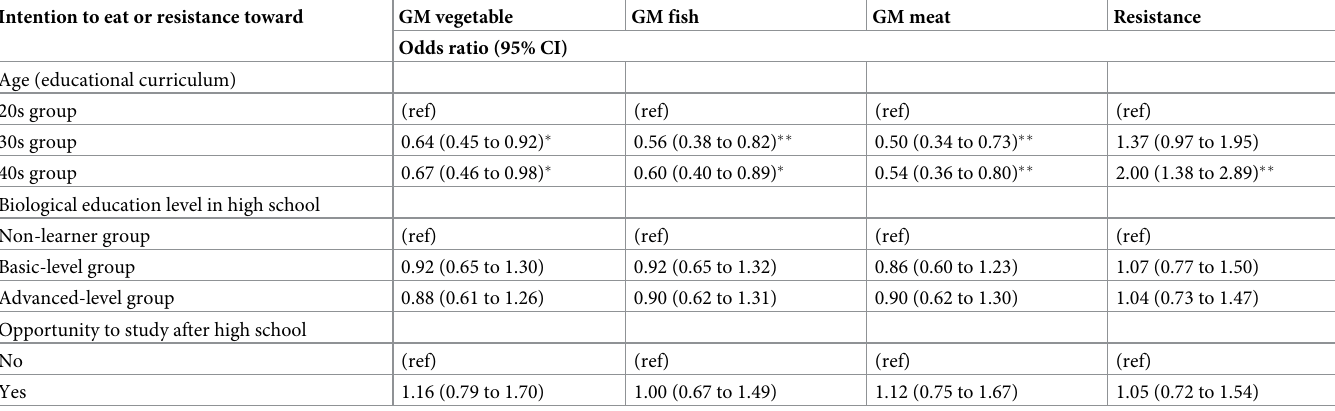
Table 6. Odds ratios of logistic regression analysis explaining acceptance of GM food according to high school biology education. Intention to eat or resistance